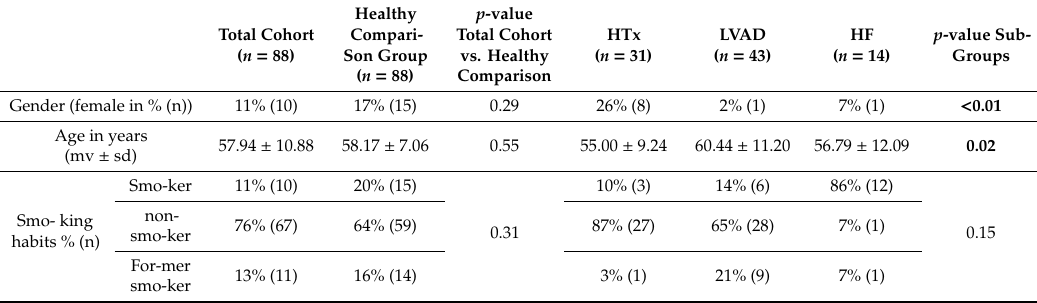
Table 2. Patient characteristics, significance level: p < 0.05.